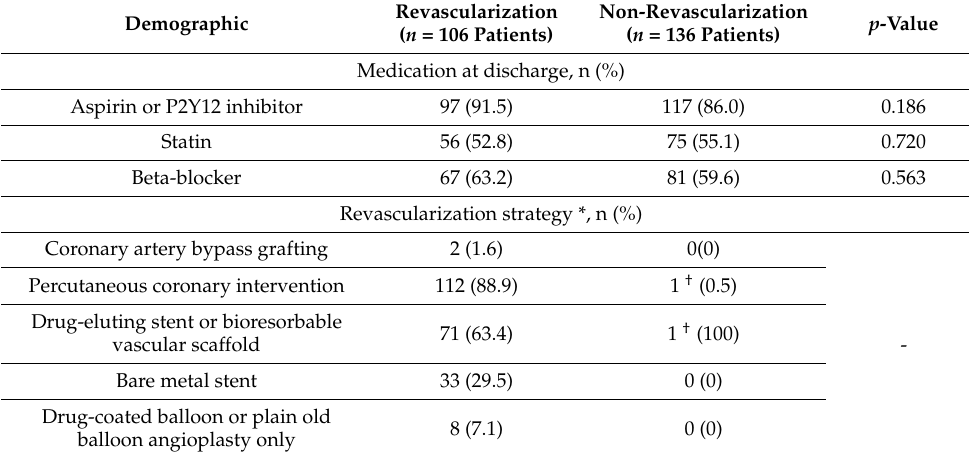
Table 2. Medication at discharge and revascularization strategy of patients with CKD who received FFR examination at NTUH, stratified by FFR ≤ 0.8 (revascularization) and FFR > 0.8 (non-revascularization).